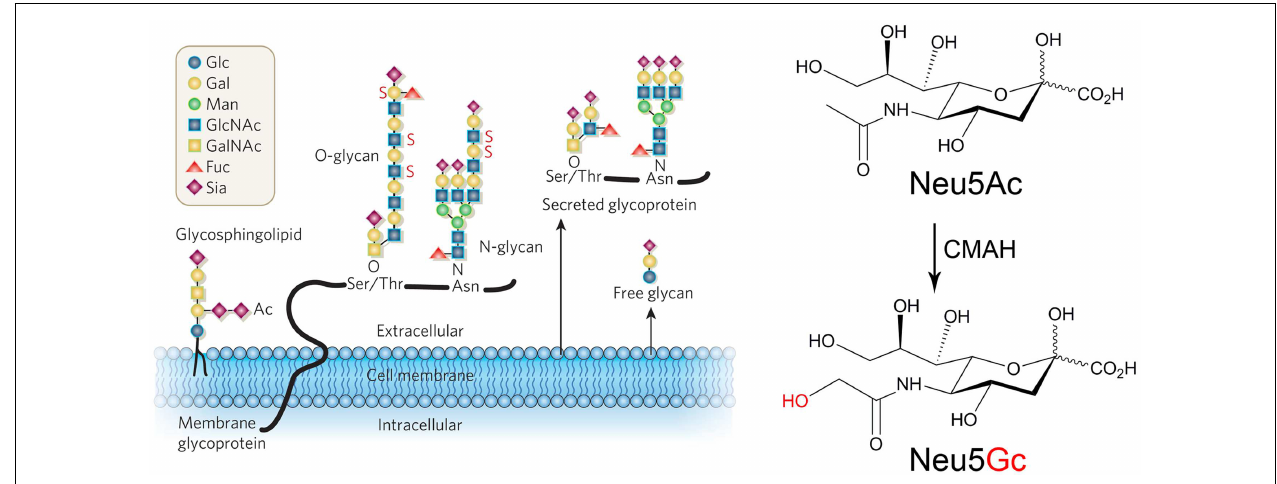
unspecified; S, sulfate ester. Right panel: the two main mammalian sialic acids Neu5Ac ( N -acetylneuraminic acid) and Neu5Gc ( N -glycolylneuraminic acid) differ by one oxygen atom, which is added by the enzyme cytidine monophosphate N -acetylneuraminic acid hydroxylase (CMAH) in the cytosol. Humans lack this enzymatic activity due to an inactivating mutation of the CMAH gene. Reproduced fromVarki (34).